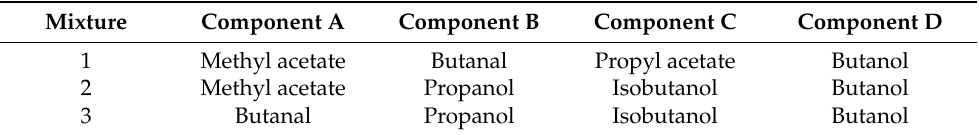
Table 1. Investigated feed mixtures. The boiling order of the components was from A light boiler to D heavy